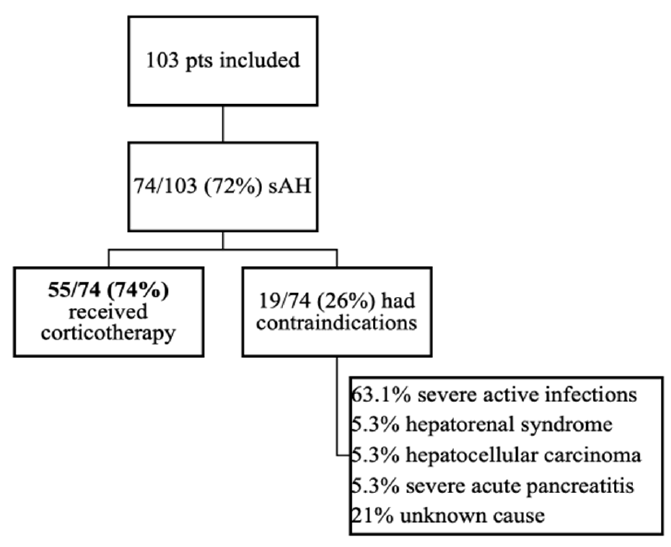
Figure 1. Patients included in the study.